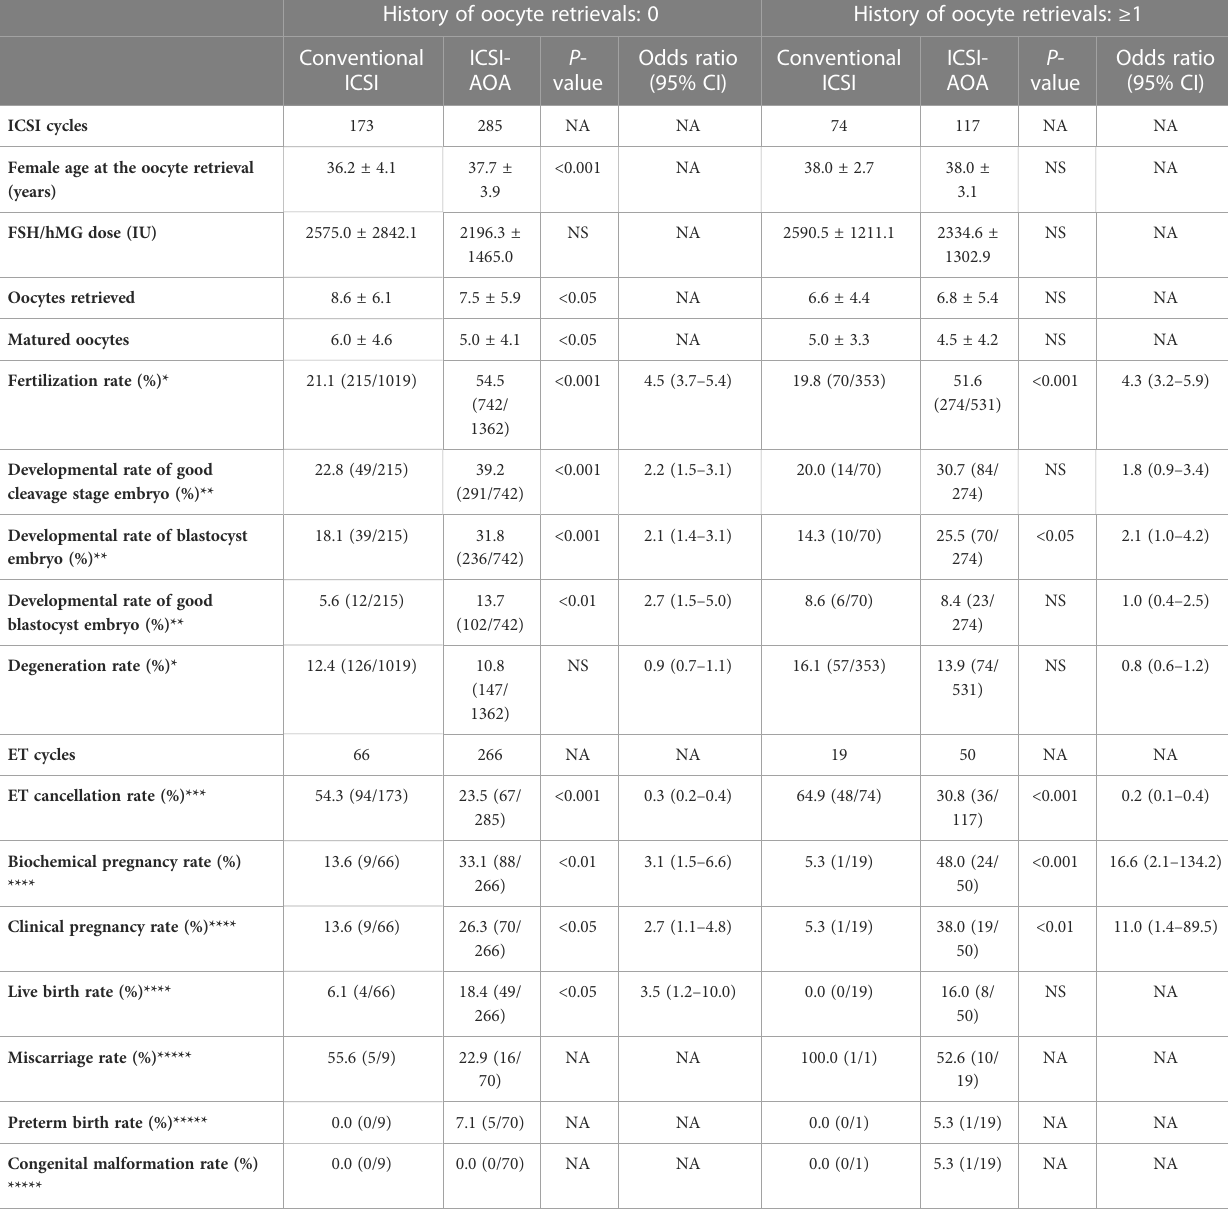
TABLE 3 Embryological and clinical outcomes after intracytoplasmic sperm injection (ICSI), and subsequent arti fi cial oocyte activation (AOA) treatment, distributed based on the history of oocyte retrievals. History of oocyte retrievals: